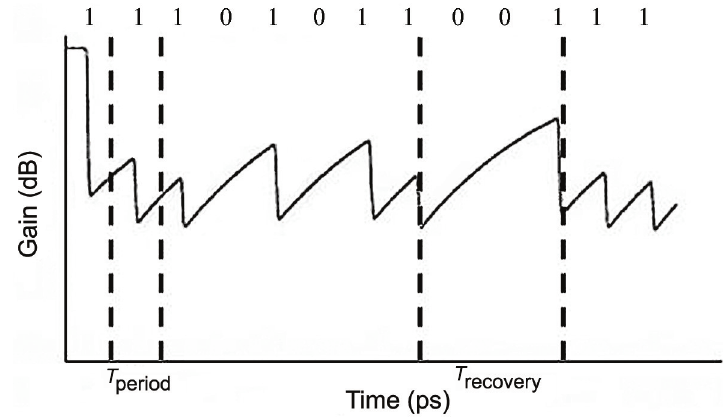
Figure 2. Evolution of semiconductor optical amplifier (SOA) gain in response to data train input of repetition period, T period , such that pulses arrive faster than the interval available for SOA carrier replenishment, T recovery